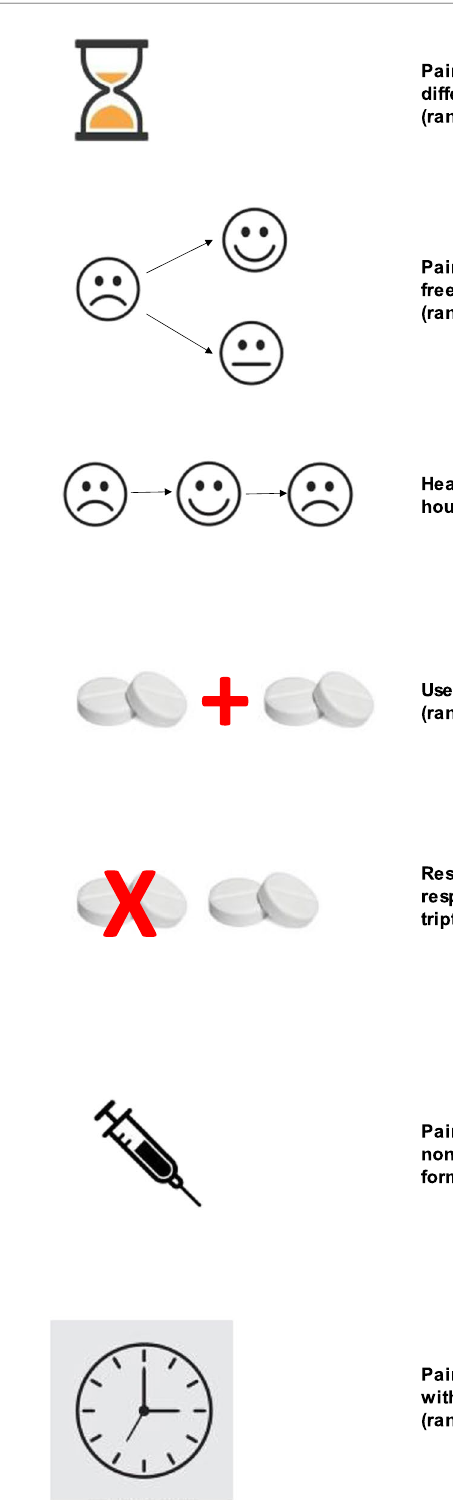
Fig. 2 Summary of findings of the systematic review. Bars represent percentage ranges in the reviewed studies. Obs indicates observational studies; RCTs, randomized controlled